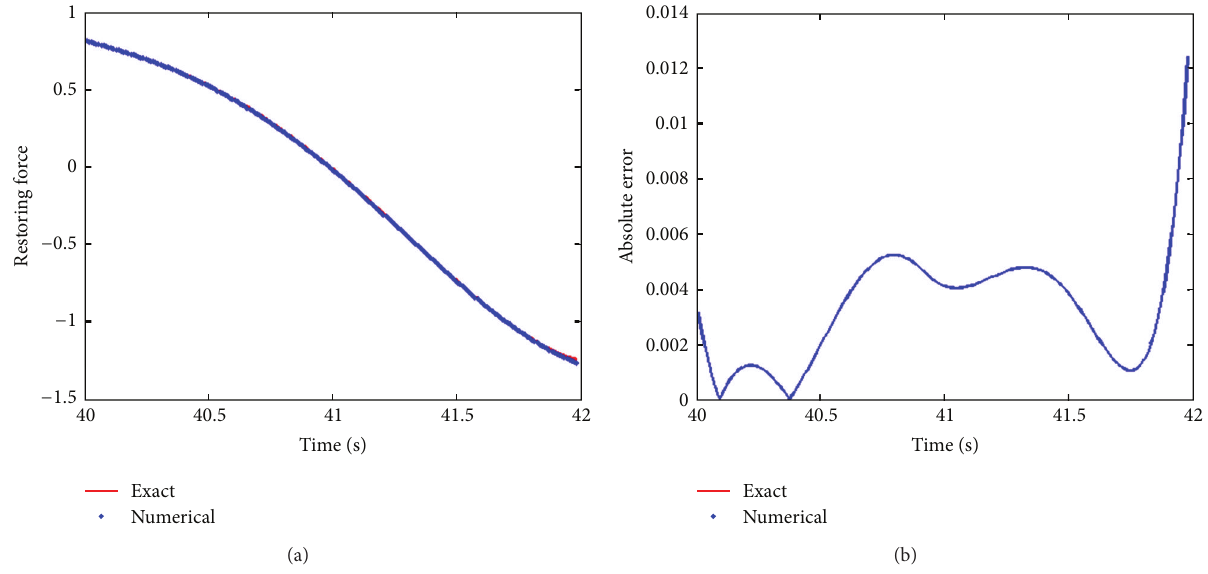
Figure 12: For Example 3, (a) comparing estimated and exact restoring forces and (b) displaying the estimation error of restoring